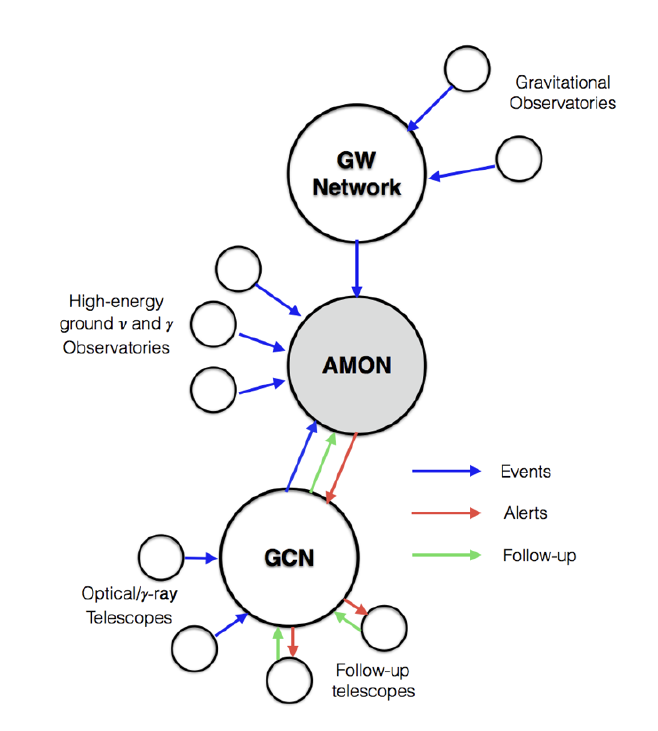
Figure 1. The AMON network. AMON receives information from triggering